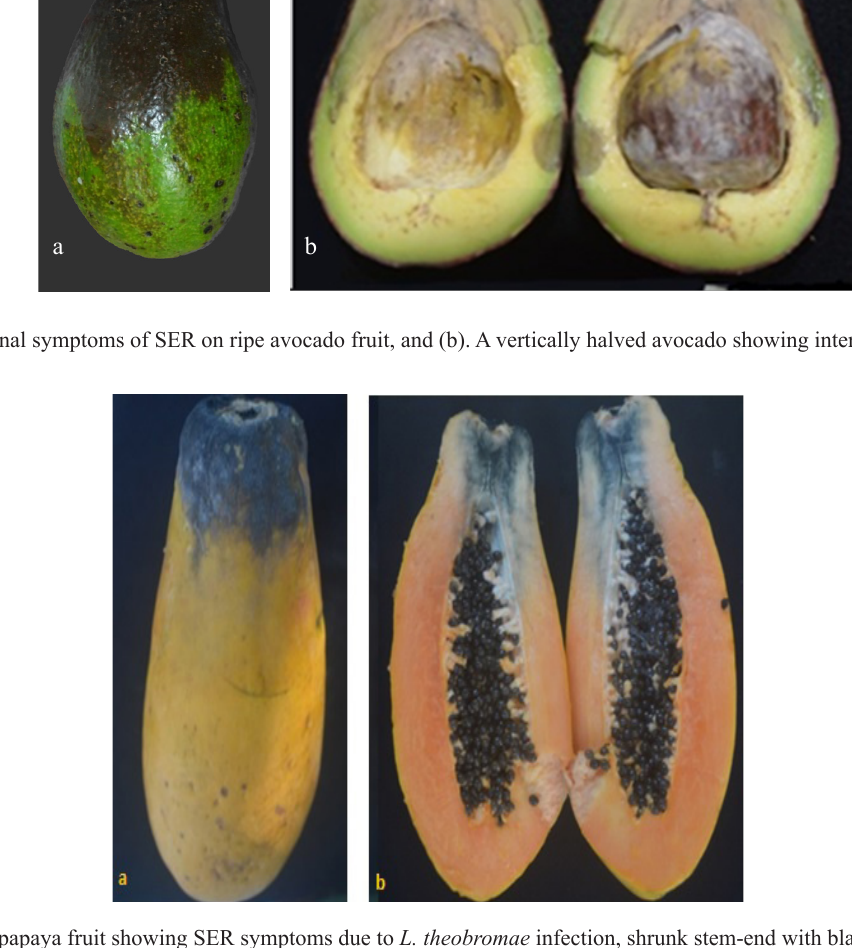
Figure 4: (a) Ripe papaya fruit showing SER symptoms due to L. theobromae infection, shrunk stem-end with black color outer mycelial growth, and (b) Vertically halved papaya fruit showing a large area of softened pulp and blackish fungal